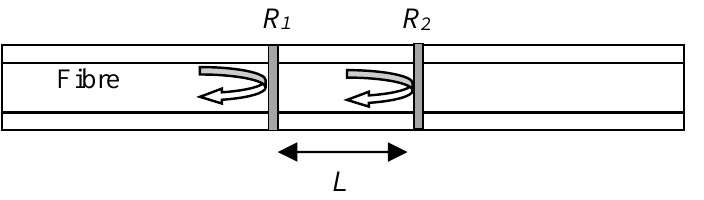
Figure 4. Principle of interferometric Figure 3. Principle of interferometric sensors.